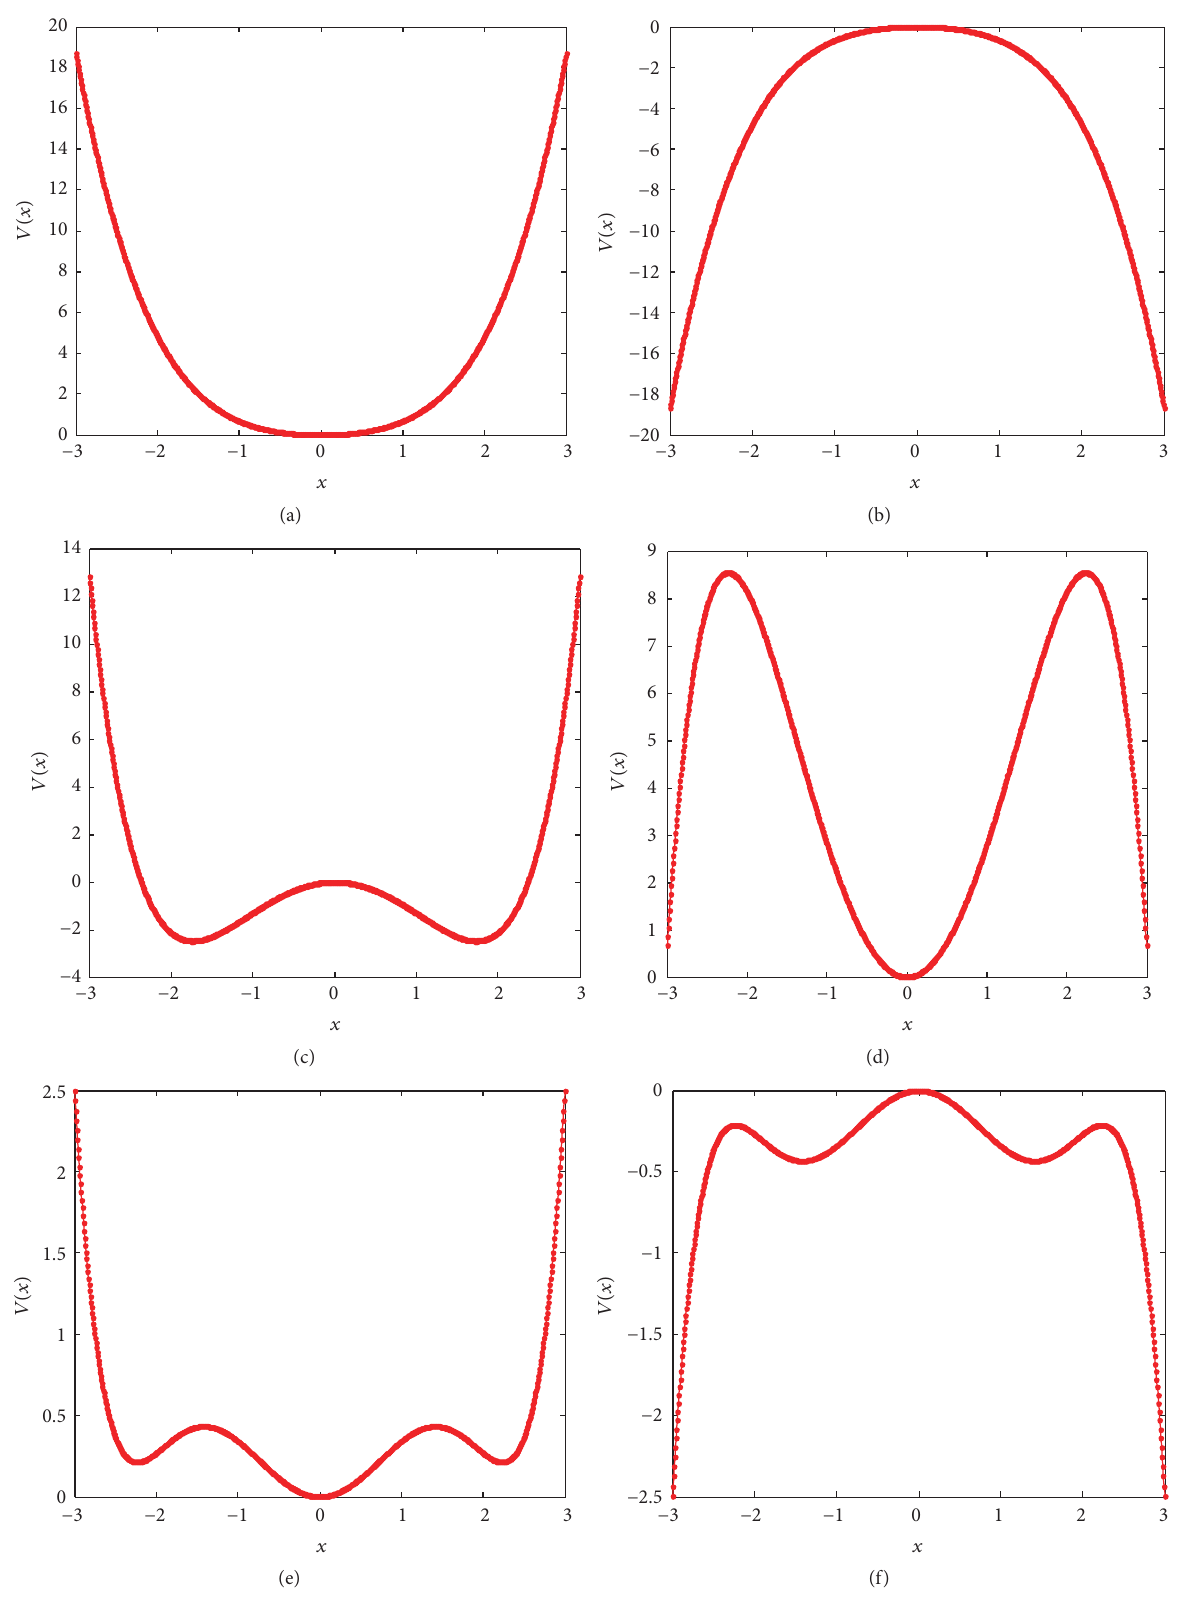
Figure 1: The smooth potential function, 𝑉(𝑥) , of the 𝜙 6 -oscillators for (a) single-well: 𝛼 = 0.5 and 𝛽 = 0.175 , (b) single-hump: 𝛼 = −0.5 and 𝛽 = −0.175 , (c) double-well: 𝛼 = −0.46 , 𝛽 = 0.7 , and 𝜆 = 0.1 , (d) double-hump: 𝛼 = 1.5 , 𝛽 = −0.7 , and 𝜆 = −0.1 , (e) triple-well: 𝛼 = 0.46 , 𝛽 = −0.7 , and 𝜆 = 0.1 , and (f) triple-hump: 𝛼 = −1 , 𝛽 = 0.7 , and 𝜆 = −0.1